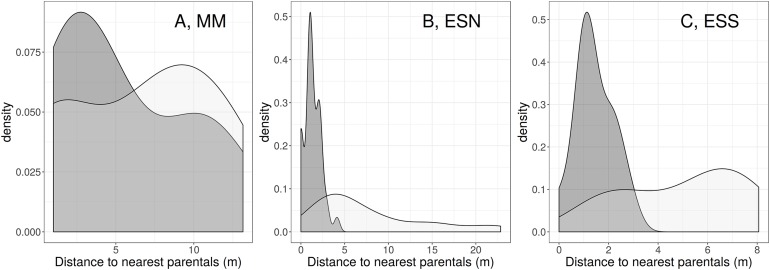
C. x subdecurrens density (number of individuals per m2) related to the distance between each C. x subdecurrens individual and the nearest individual of C. aspera and C. seridis.C. aspera: dark grey, C. seridis: light grey. Study sites: (A) MM, Marjal dels Moros; (B) ESN, El Saler North; (C) EES, El Saler South.